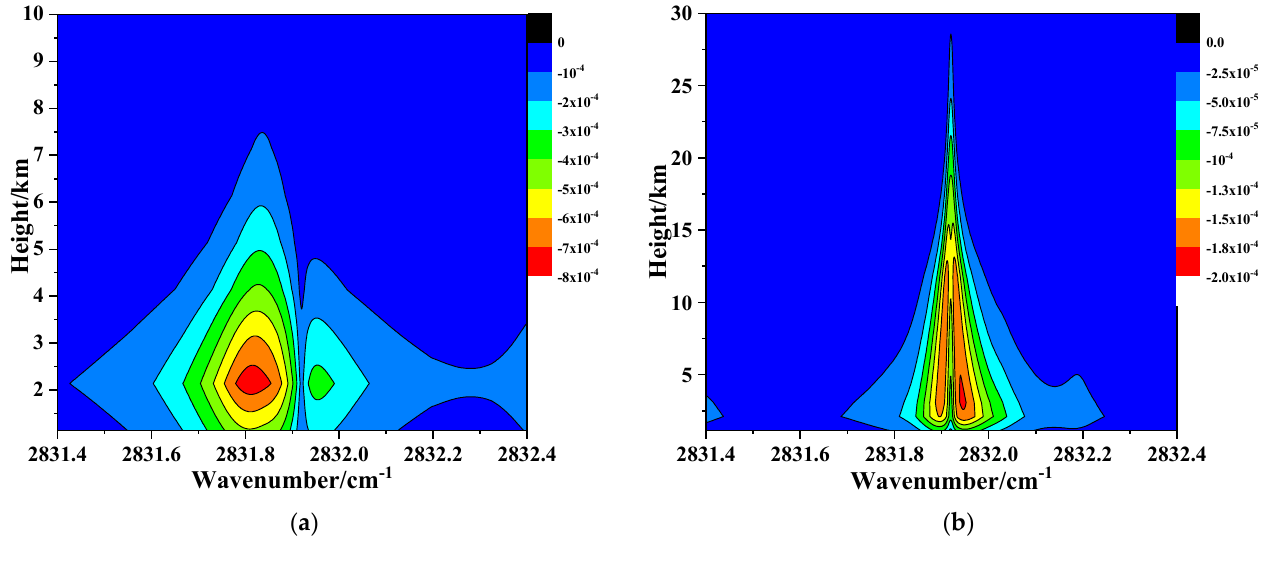
Figure 13. The Jacobian value of ( a ) HDO and ( b ) CH 4 .